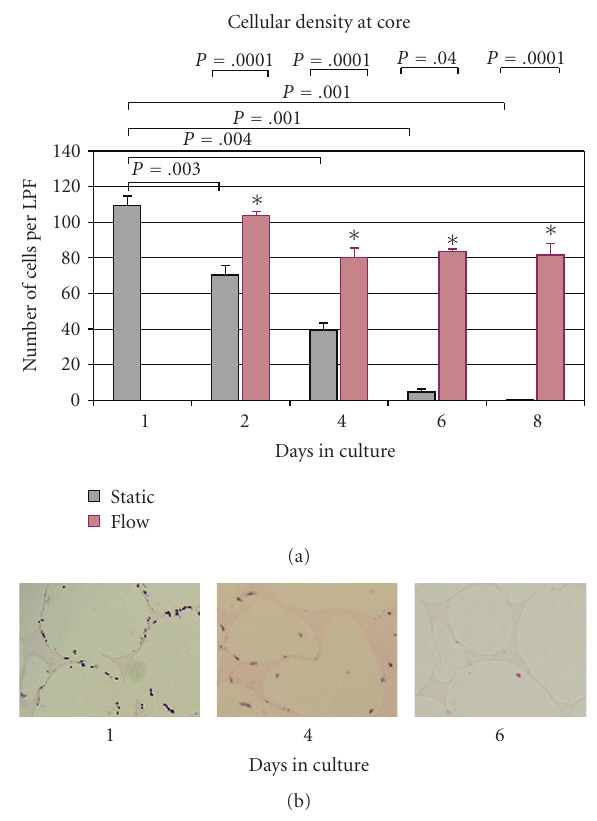
Figure 4: (a) Cell density in the core exhibited a rapid decline in sca ff olds cultured in static conditions. In contrast, core cell density was maintained in sca ff olds treated with flow-perfusion culture. (b) Photomicrograph of MC3T3-E1 cells in the core of a polyurethane sca ff old in static culture. The cusp of viability for cells in the core lies between day 4 and day 6 for samples in static culture. Between these time points, there was an 88% reduction in cell density.